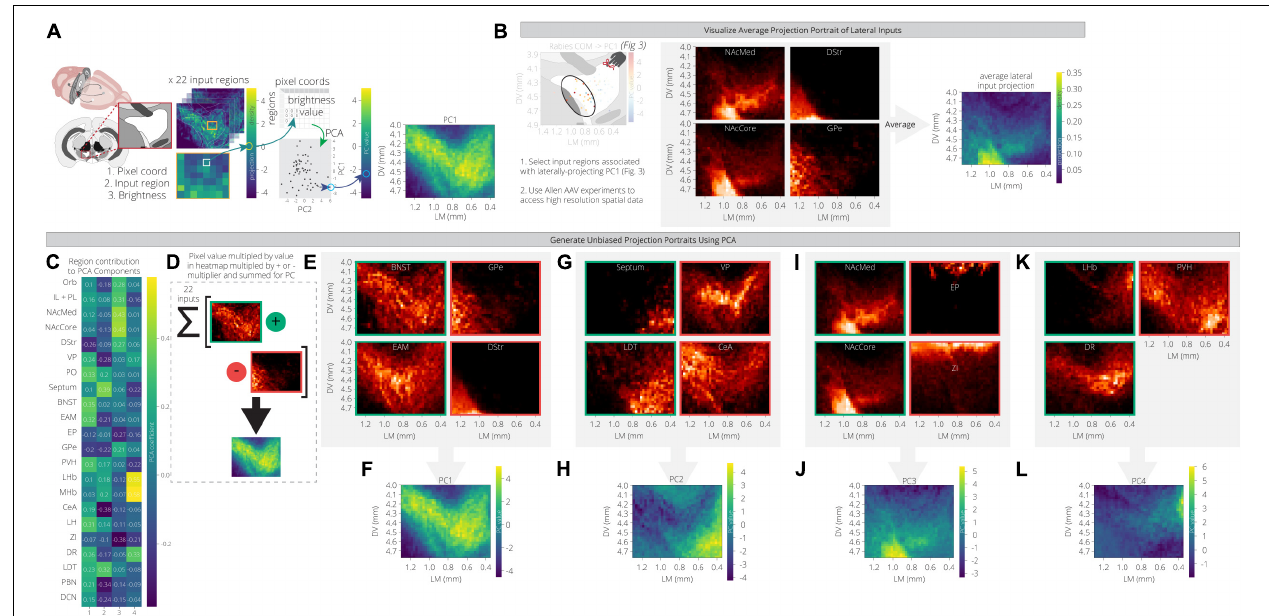
FIGURE 4 | PCA of data from the Allen Mouse Brain Connectivity Atlas reveals projection archetypes across different input groups. (A) Schematic of analysis. Sample projections to the VTA were pulled from the Allen Mouse Connectivity Atlas for 22 input regions. Pixel values representing projection density were pulled from the coronal slice for each region to generate a table of 2,058 pixel coordinates x 22 regions. PCA found a linear combination of input regions that maximizes variation across the pixels. Each pixel is then visualized on a coronal slice of the VTA with its PC value, revealing the most common projection portrait. (B) Brain regions that preferentially provide inputs to VTA → NAcLat cells were selected as a test case to see if they might have a common projection pattern. Sample projections from these regions to the VTA are shown from the Allen data, along with their average projection portrait. (C) Heatmap of each input region’s contribution to the first four principal components. (D) Positive and negative contributing regions to each principal component are summed according to their sign in order to generate the principal component projection portrait. (E–L) Example projection portraits are shown for the major positive and negative contributing regions for each of the first four principal components. The projection archetypes corresponding with these principal components are shown in panels (F,H,J,L)